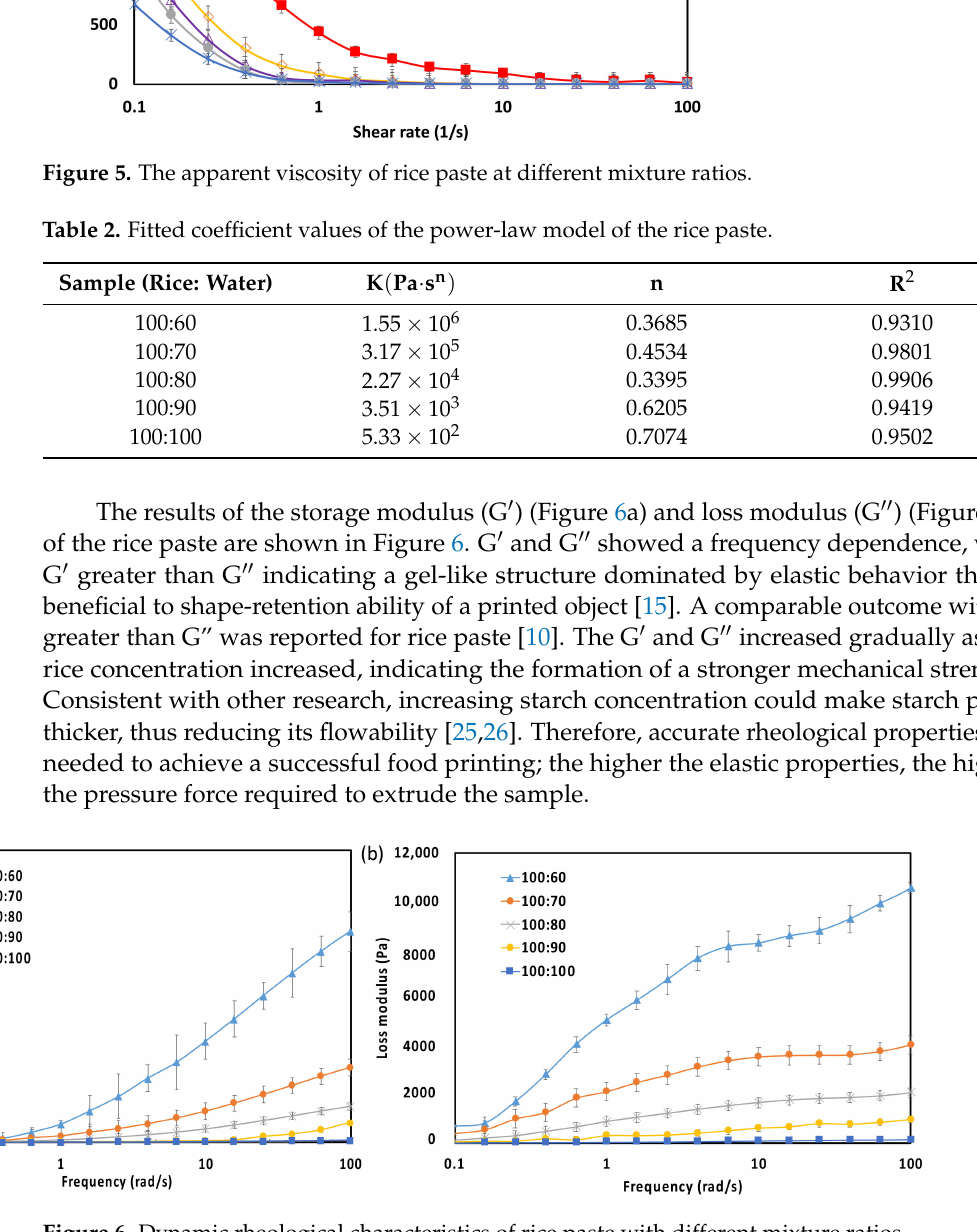
Figure 6. Dynamic rheological characteristics of rice paste with different mixture